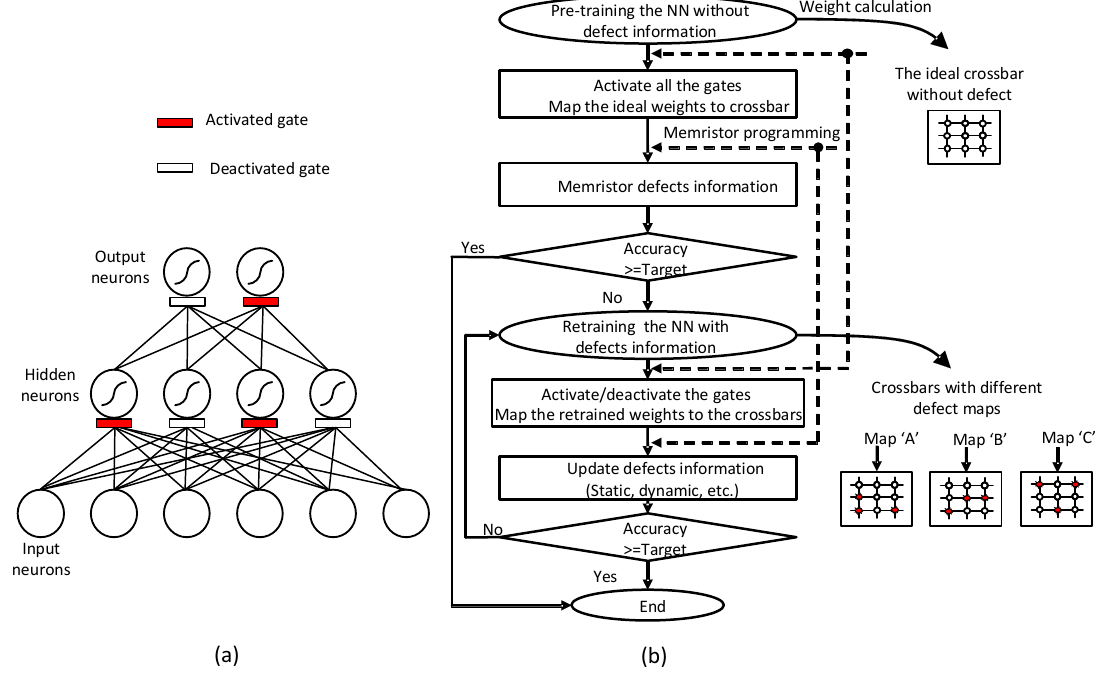
Figure 2. ( a ) The neural network with the partial gating. Here the neurons responsible to the output error are activated and the others related little to the error are deactivated. By doing so, the retraining time can be saved because only the connections belonging to the activated gates are programmed during the retraining. ( b ) The flowchart of training steps of the proposed partial-gated memristor network. During the pre-training, the ideal crossbar is assumed and all of the weights are trained. During the retraining, parts of the gates are activated and only the connections to the gates are retrained. By doing so, we can save a lot of programming time and power during the retraining.